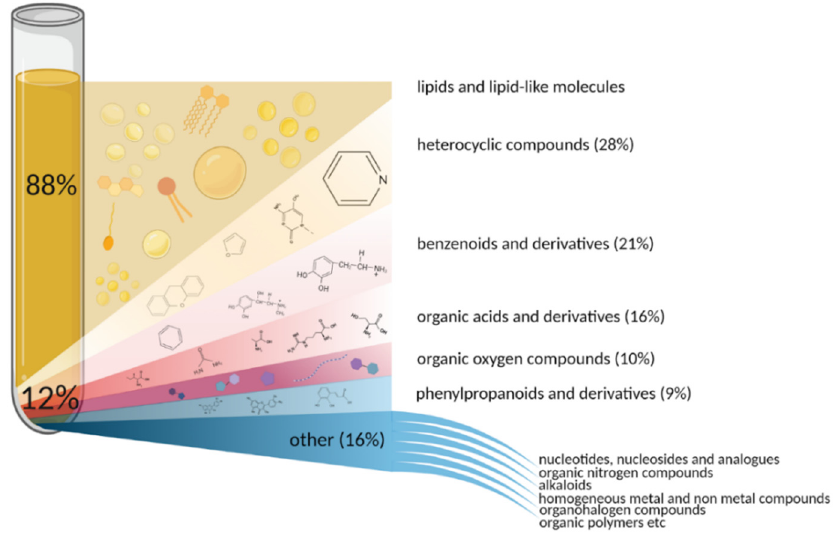
Figure 1. Diversity of chemical substances comprising human blood metabolome based on HMDB 5.0.